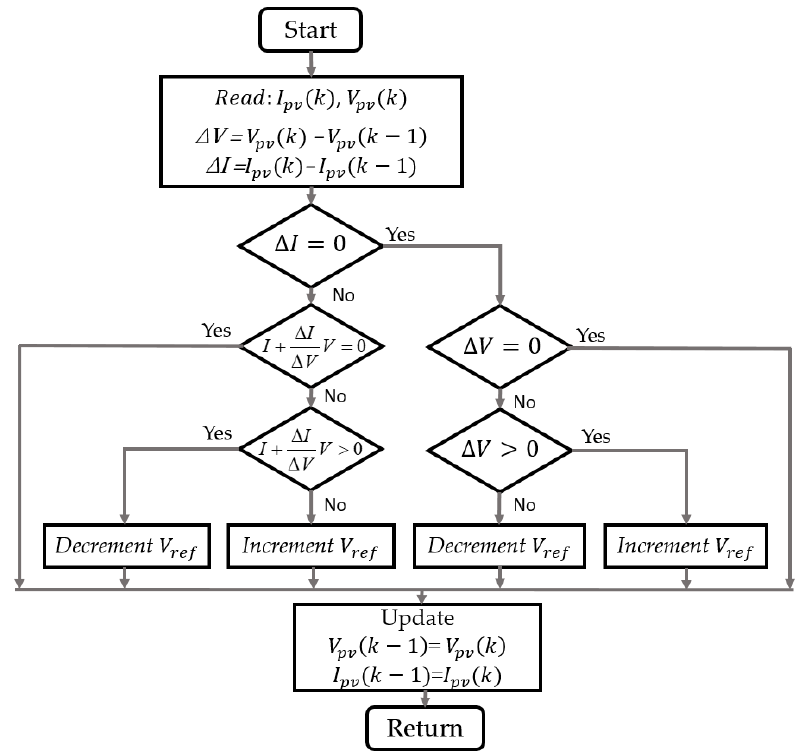
Figure 6. Flowchart of INR algorithm.